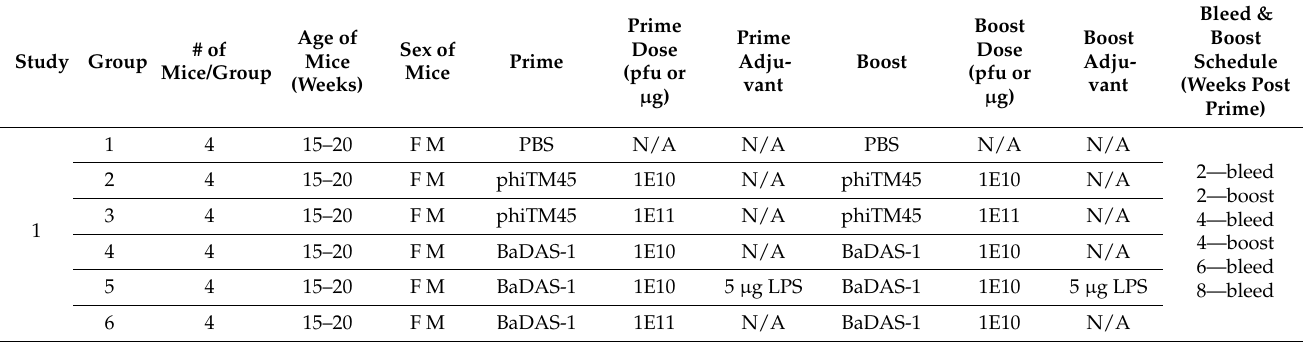
Table 2. Studies of mice inoculations with vaccine